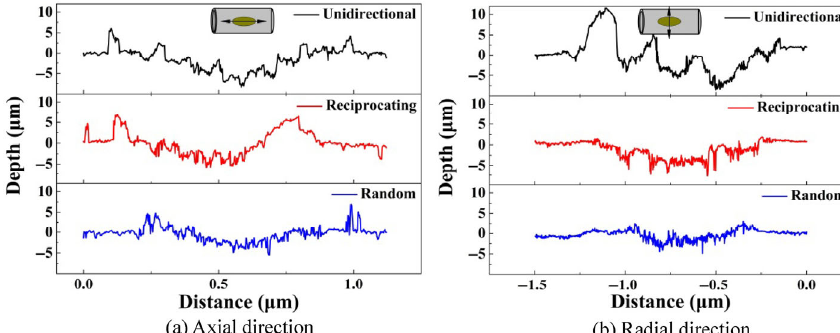
Fig. 14 Profiles of the tube wear